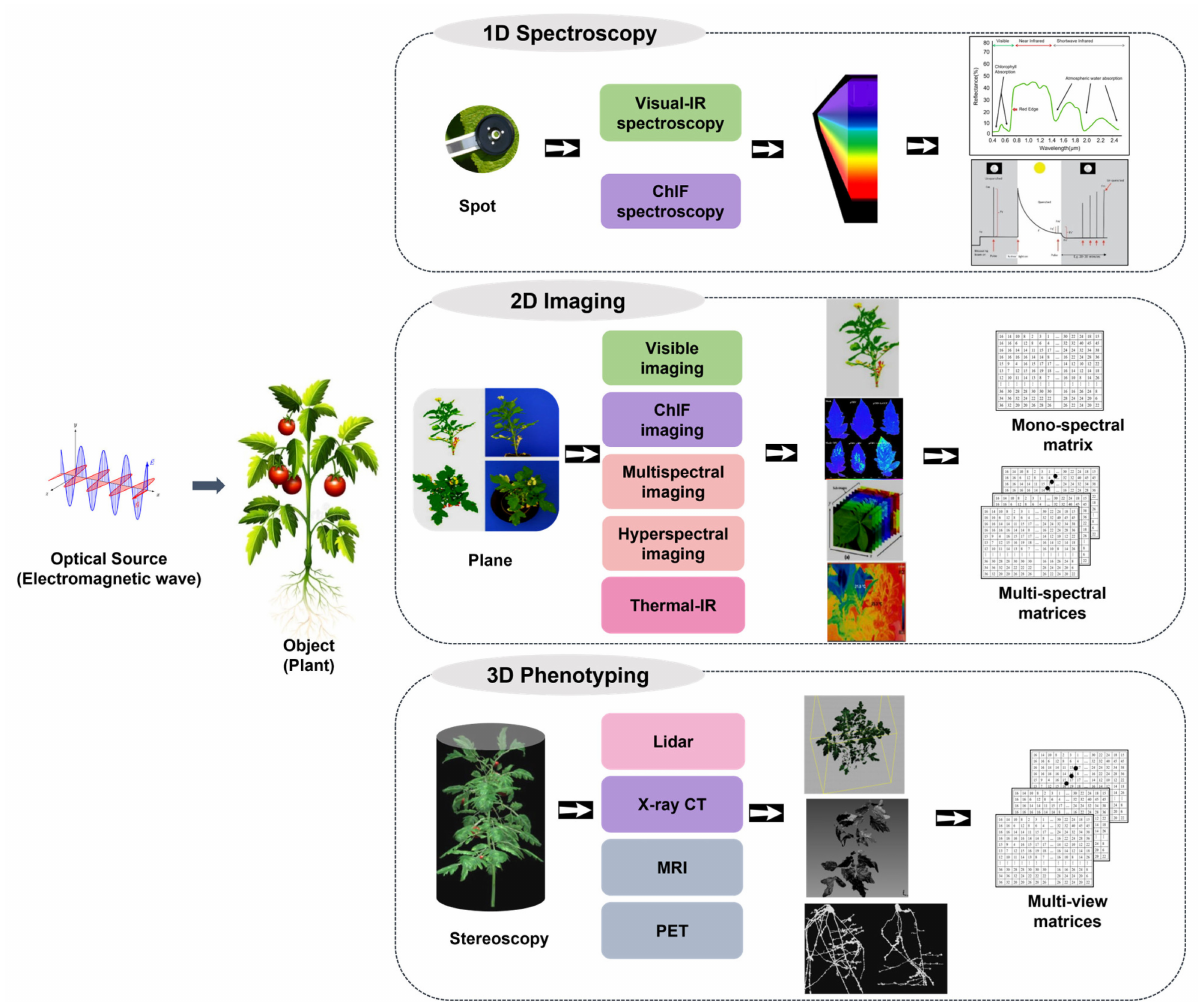
Figure 1. Data-acquisition process for non-destructive optical-based plant stress phenotyping, involv- ing 1D spectroscopy, 2D imaging, and 3D phenotyping. One-dimensional spectroscopy techniques include Visible-IR and ChlF spectroscopy; two-dimensional imaging techniques include visible, multispectral, hyperspectral, IR, and thermal-IR imaging; three-dimensional phenotyping techniques include LiDAR, X-ray CT, MRI, and PET. The corresponding acquired raw data and data type are also shown in this